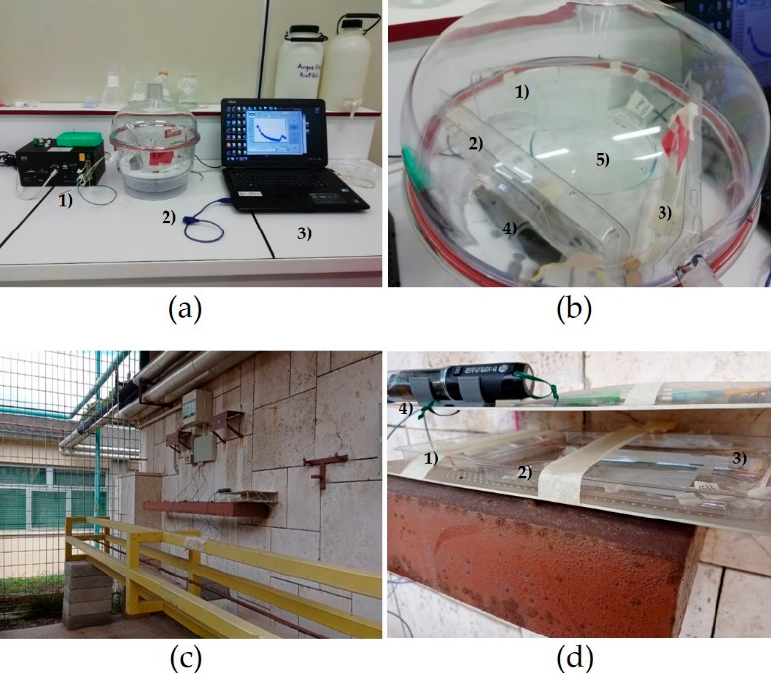
Figure 1. Experimental set-ups. ( a ) Measurements with the saturated salt solutions: (1) FBG interrogation system; (2) humidity chamber; (3) laptop. ( b ) Close view of the humidity chamber: (1–2–3) samples; (4) thermo-hygrometer; (5) salt saturated solution. ( c ) Location for the measurements in the open air. ( d ) Close view of the tray with the samples: (1–2–3) samples; (4) thermo-hygrometer.